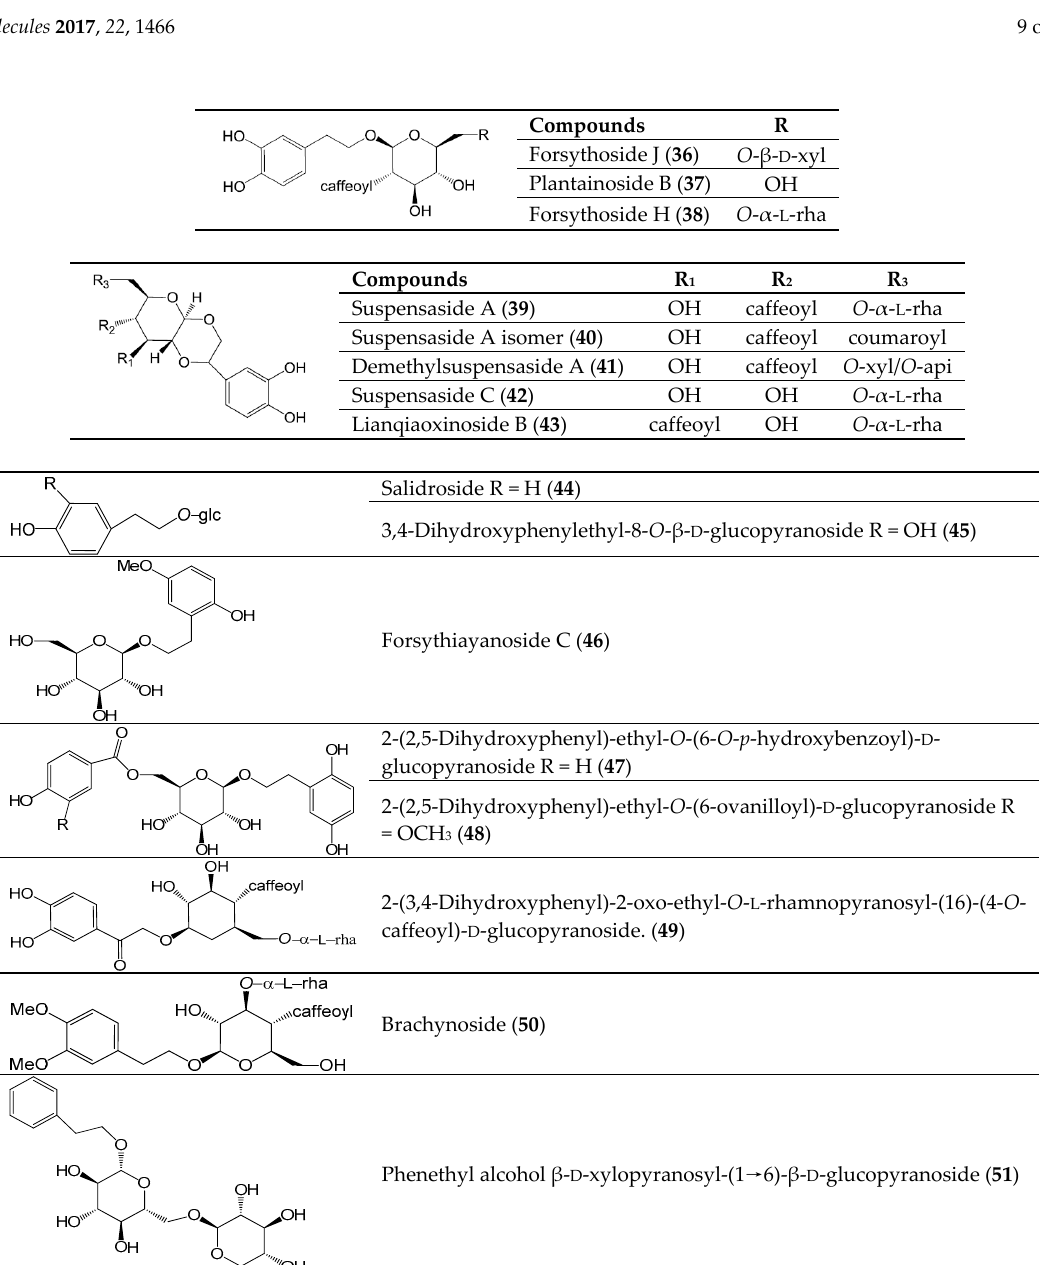
Figure 1. Chemical structures of phenylethanoid glycosides in Forsythiae Fructus.